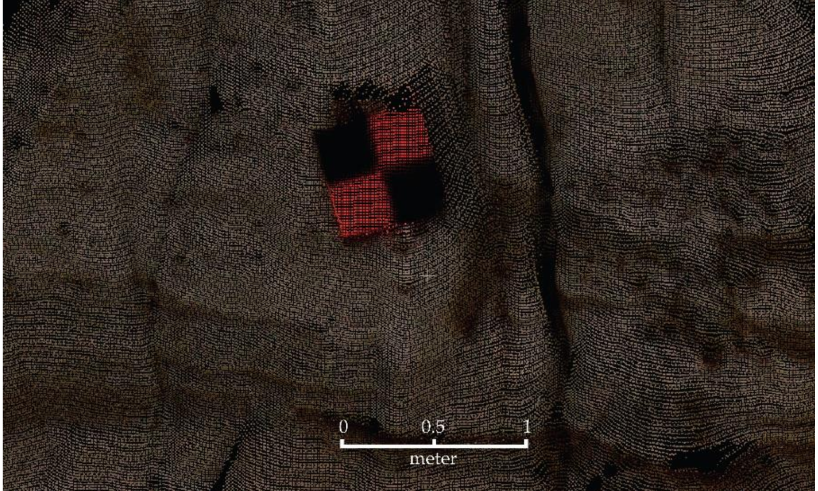
Figure 2. Section of merged TLS point cloud, prior to vegetation and noise removal. Note the GCP target (0.6 × 0.6 m, approximately 2600 points) and rough slope topography composed of rills and drainages void of